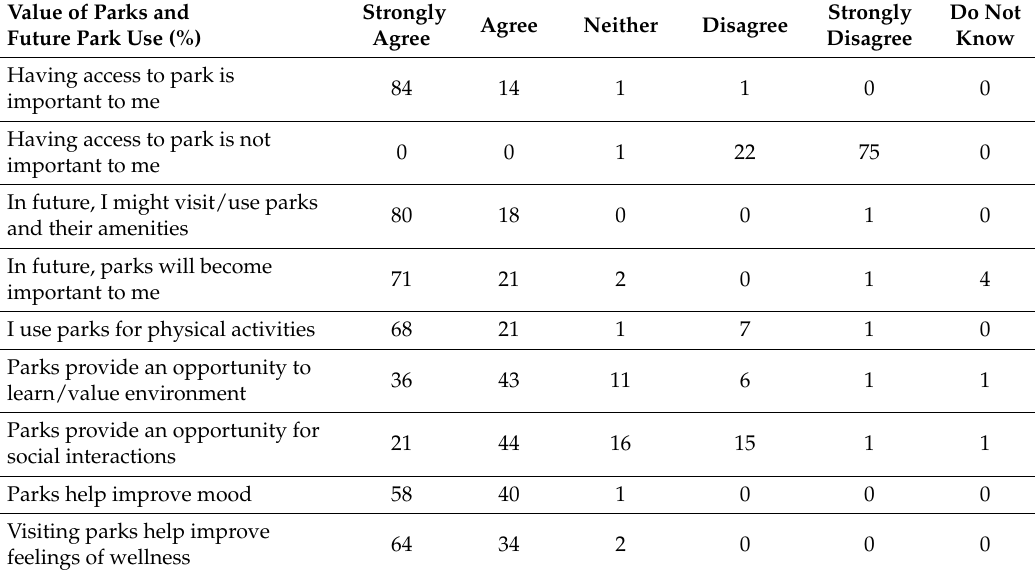
Table 3. Value of parks.